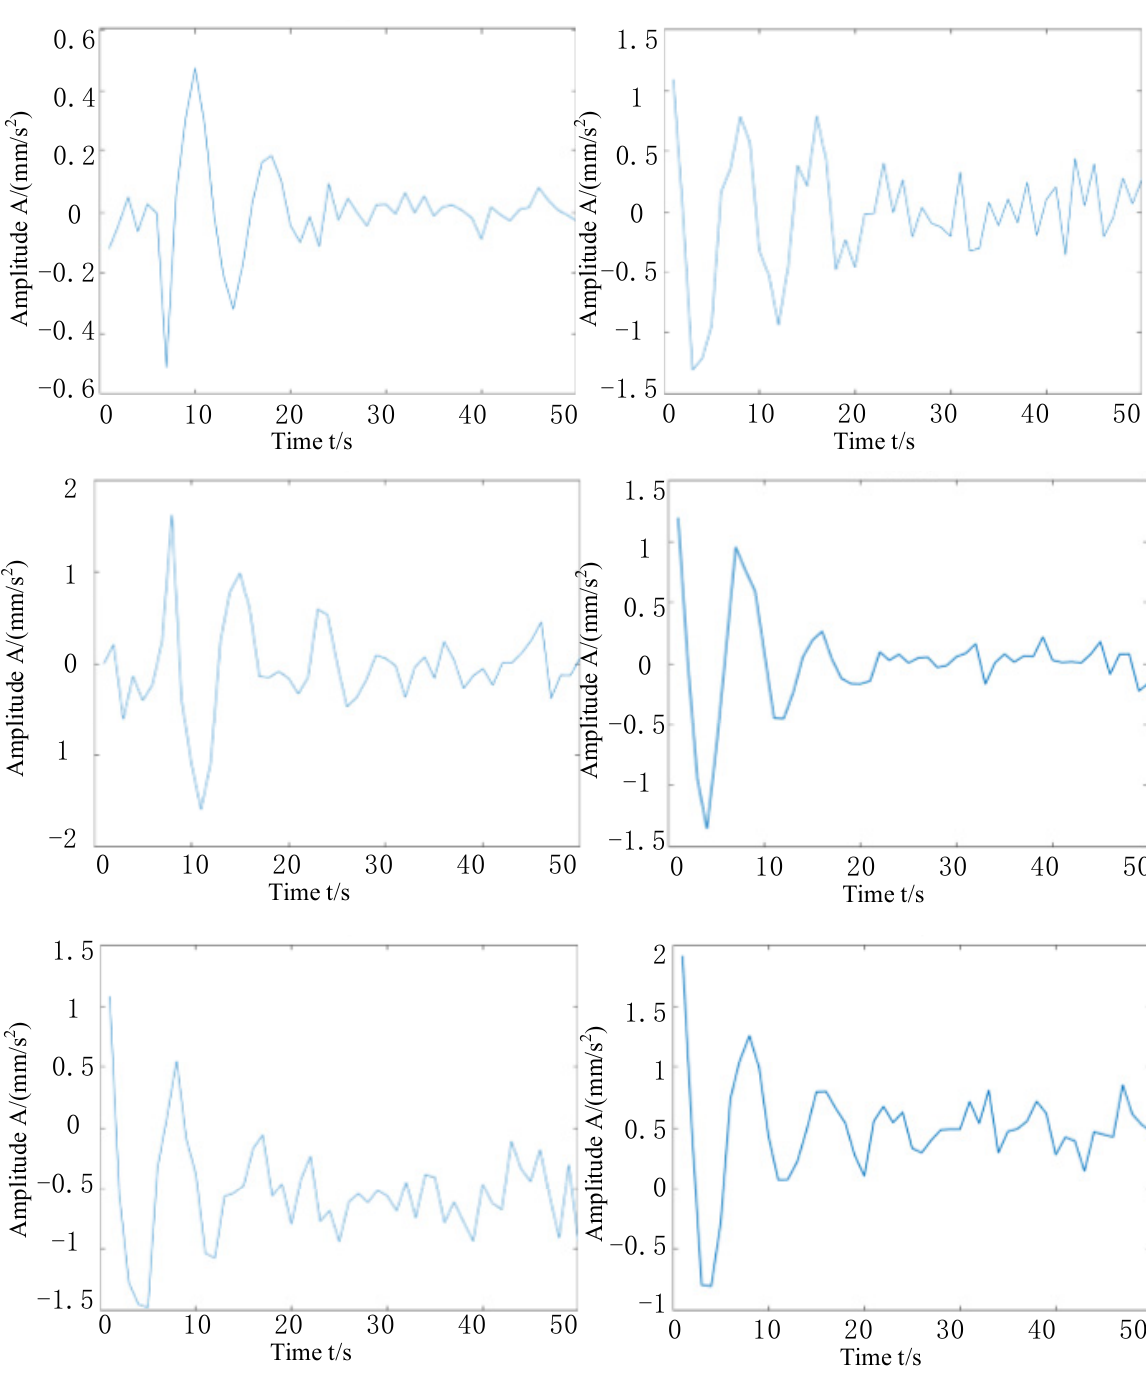
of the composite signal without adding noise and harmonic components, and the transient impact period is discernible. Using the classical K-SVD algorithm and the orthogonal matching pursuit algorithm, the time-domain waveform of the sparse signal is obtained, as in Figure 13a. The reconstructed signal is still disturbed by noise and harmonic compo- nents, and the transient impact period is not obvious. The envelope spectrum analysis of the sparse signal is carried out, as shown in Figure 12b; it can be seen that the spectral peak of the fault frequency and the spectral peak at the frequency doubling are more ob- vious, and all of the transient shock components in the cut-off period are identified. The higher harmonics are almost eliminated. In Figure 13b it is found that the spectral peaks at the multiplier of the fault frequency are not obvious; some transient impulse compo- nents are submerged in the noise, and are difficult to identify. This shows the effectiveness and reliability of this algorithm in the extraction of transient impulse components in in- tense noise.